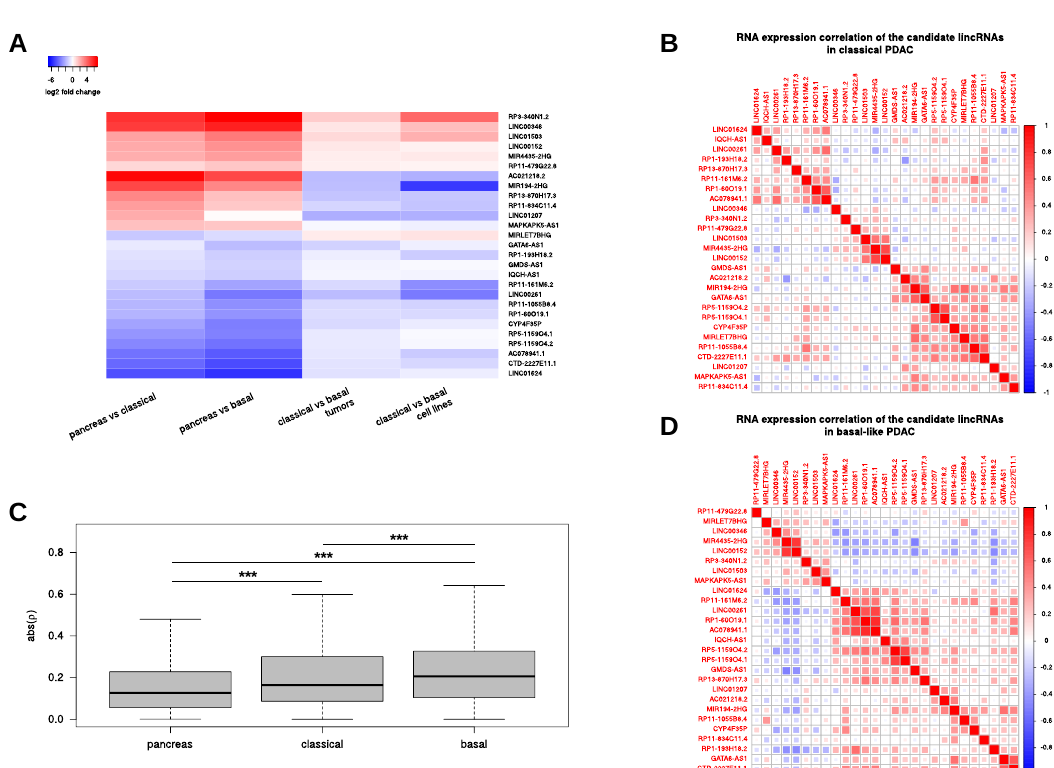
Figure 3. Expression of 27 differentially expressed and subtype-related candidate lincRNAs. ( A ) Heatmap displays log2 fold changes of 27 lincRNAs that show expression differences between tumour subtypes and normal pancreas as well as between both cancer subtypes in situ and in cellulo. ( B , D ) Spearman correlation coefficients ( ρ ) of the selected lincRNAs in classical ( B ) and basal-like ( D ) PDAC samples. ( C ) Distribution of magnitudes of Spearman correlation coefficients ( | ρ | ) obtained from correlation tests between the selected lincRNAs in pancreas and PDAC subtype